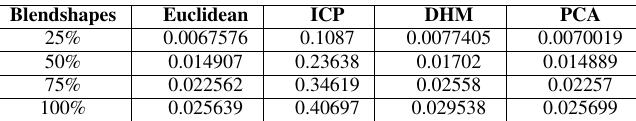
TABLE IV R ESULTS IN SECONDS OF THE PROCESSING OF THE BLENDED SETS ACCORDING TO THE TIME OF EACH ALGORITHM